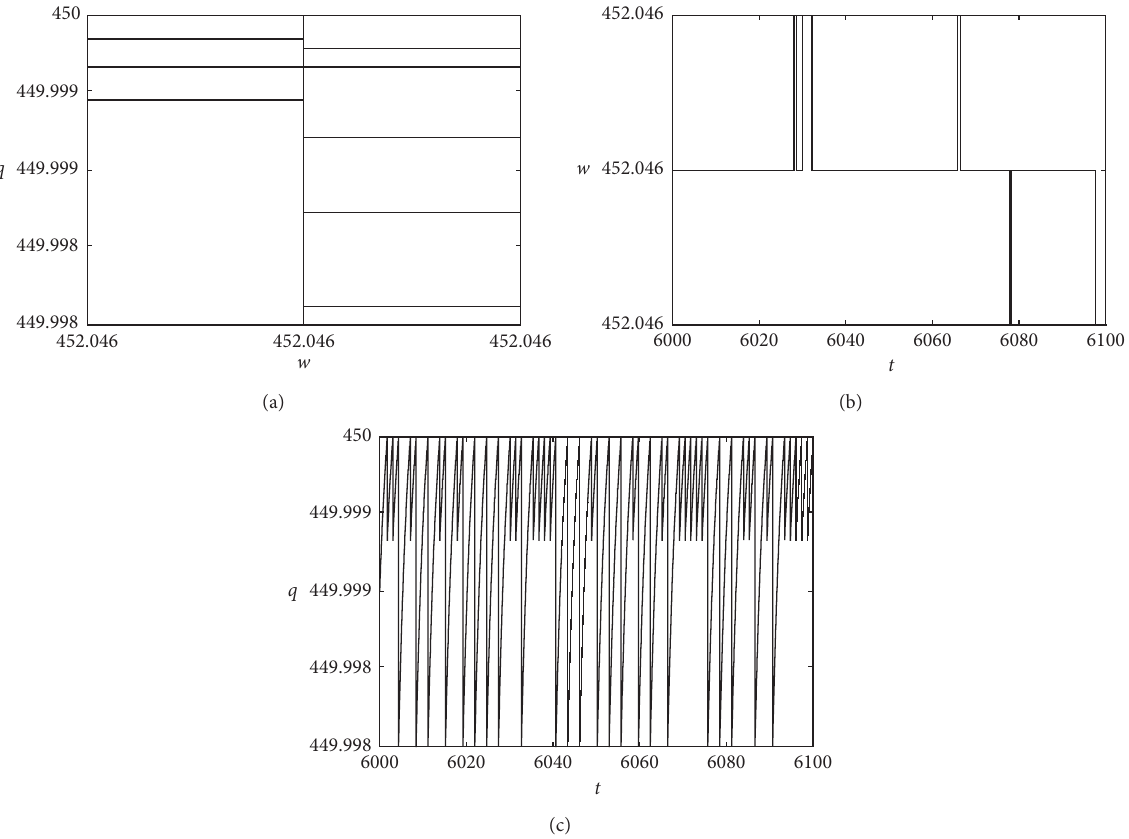
Figure 8: The irregular oscillation in system (10), where the phase portrait is in (a) and time histories in (b) and (c).